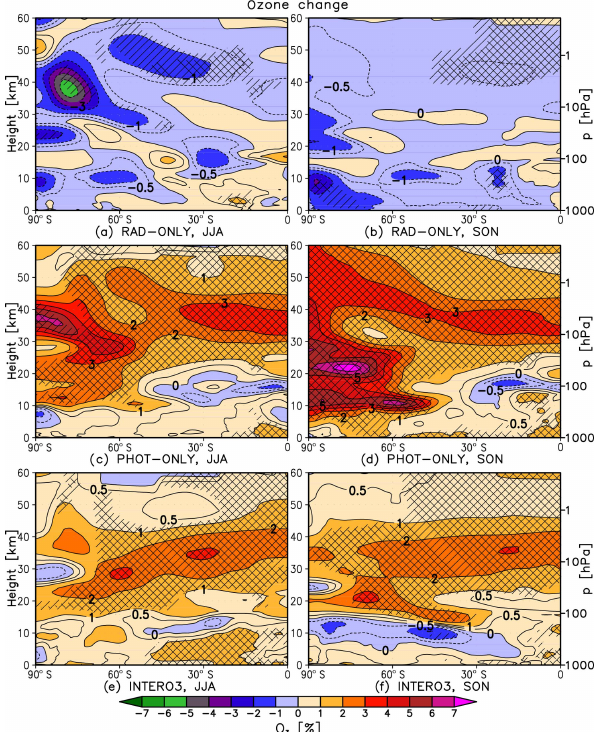
Figure 8. Seasonal mean (left: JJA, right: SON) SH zonal mean changes in ozone mixing ratios (%) between SMAX and SMIN for (a, b) RAD-ONLY, (c, d) PHOT-ONLY and (e, f) INTERO3. Sin- gle and double hatching indicate statistical significance at the 90% and 95% confidence level, respectively ( t test). Note the additional contours at ± 0 .